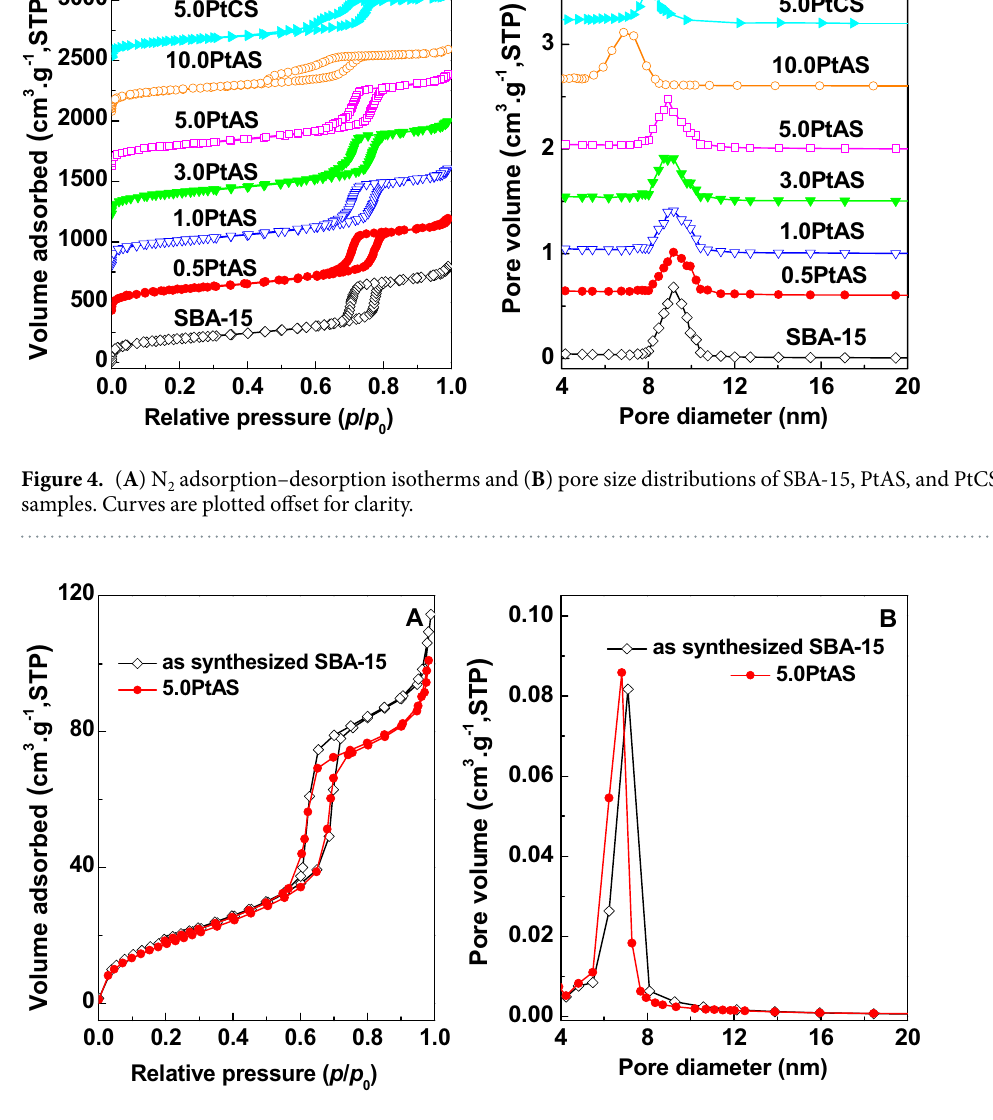
Figure 5. ( A ) N 2 adsorption-desorption isotherms and ( B ) pore size distributions of as synthesized SBA-15, and 5.0PtAS samples before